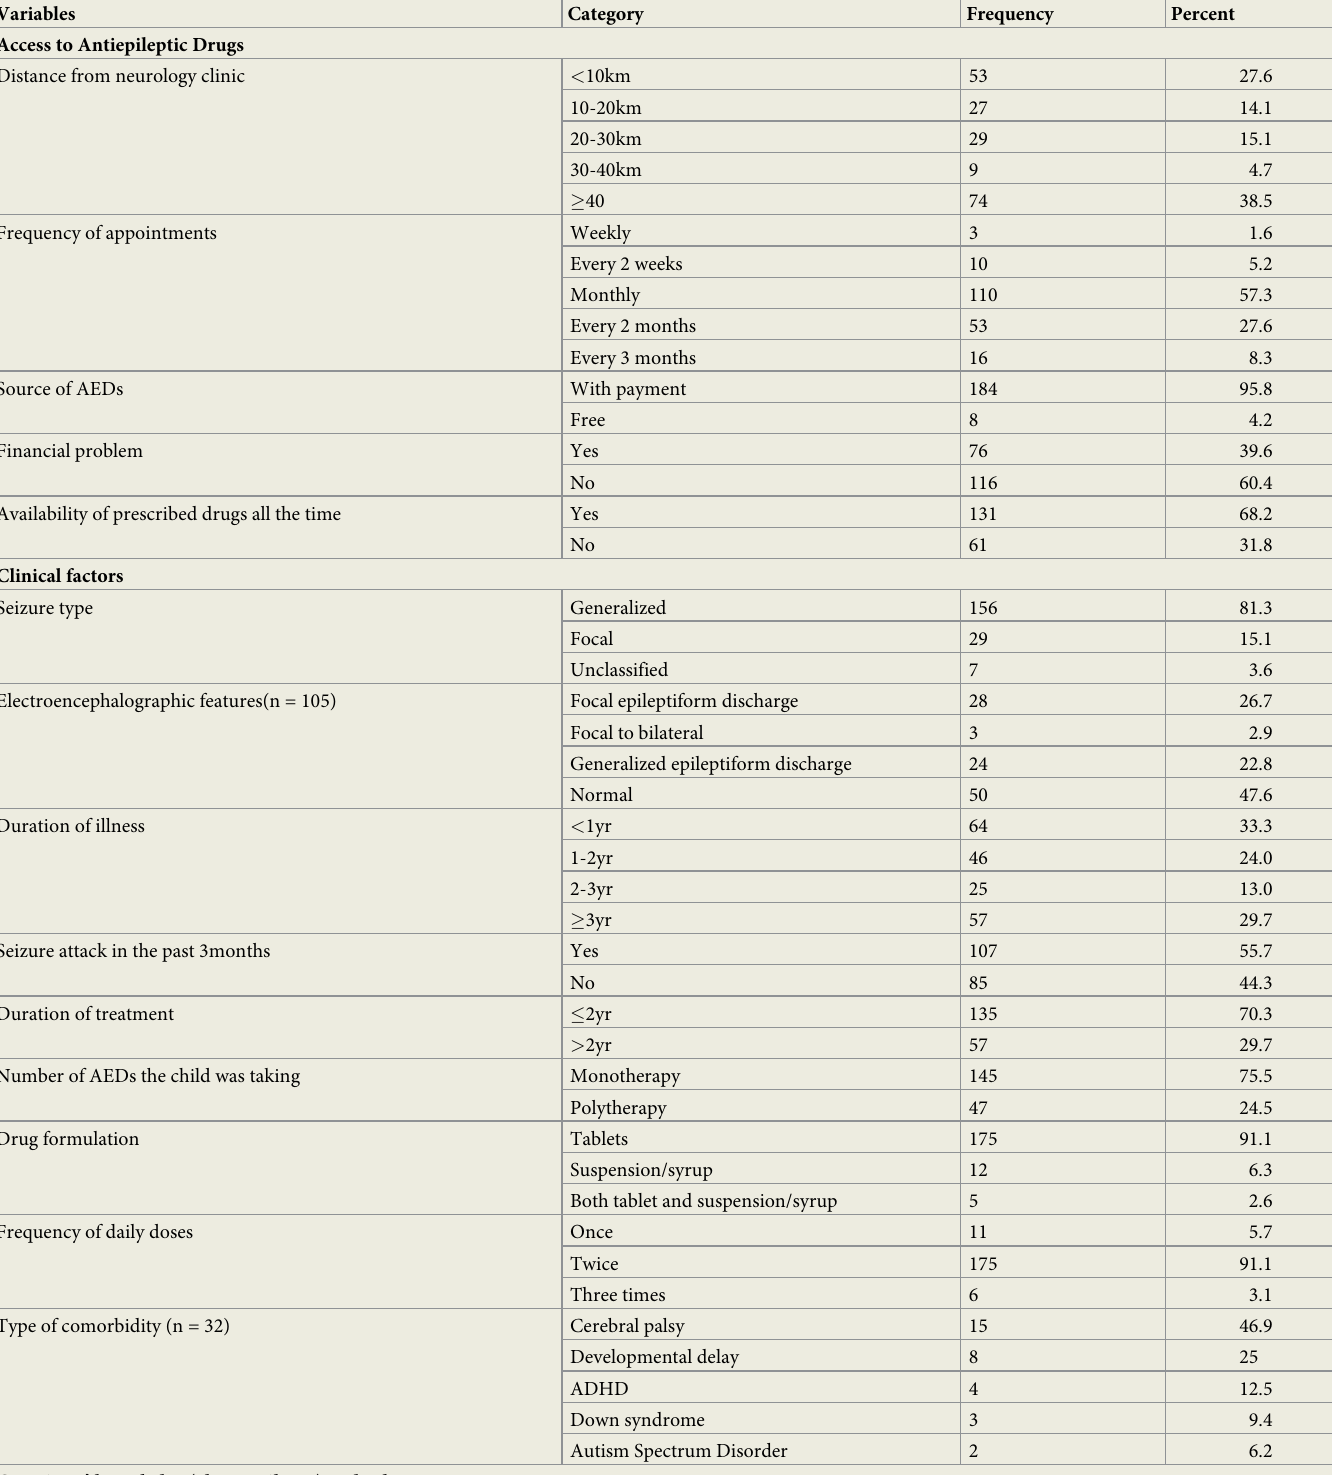
Table 2. Frequency distribution of AED adherence related characteristics (n =